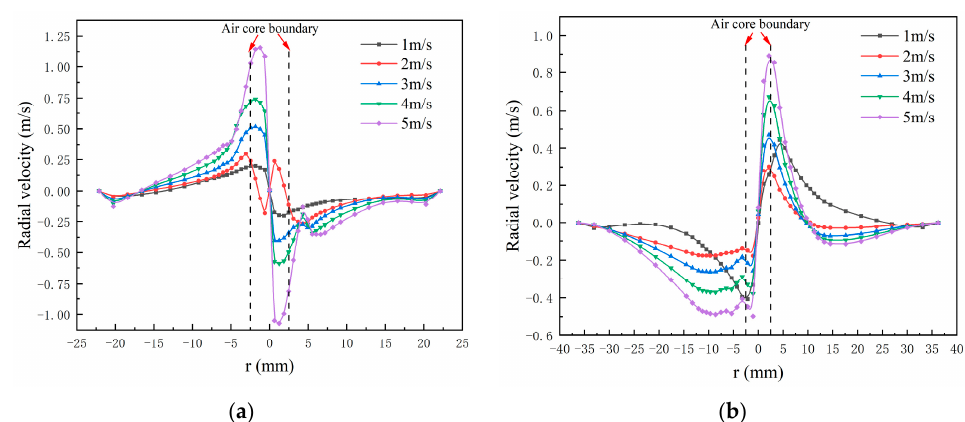
Figure 10. Distribution of the radial velocity . ( a ) z 1 = 90 mm; ( b ) z 2 = 170 mm.